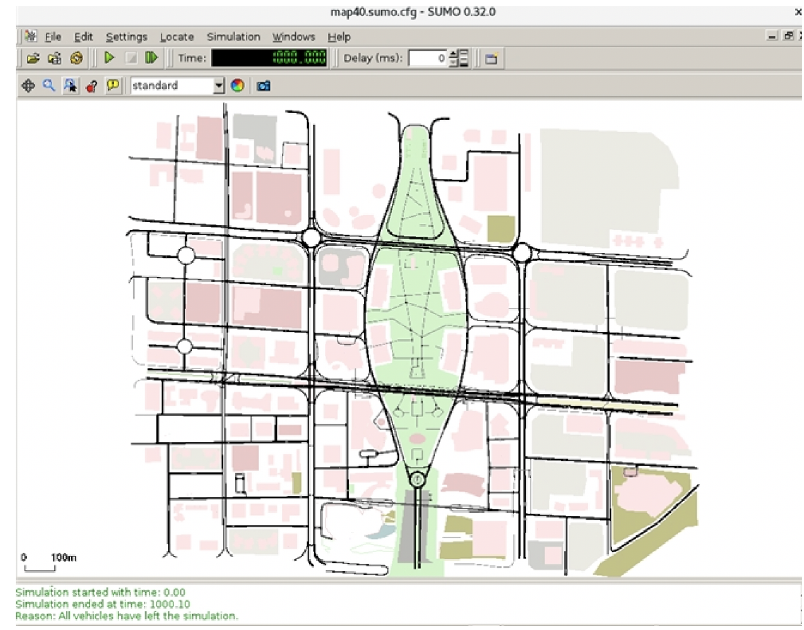
Figure 8. SUMO NET map of